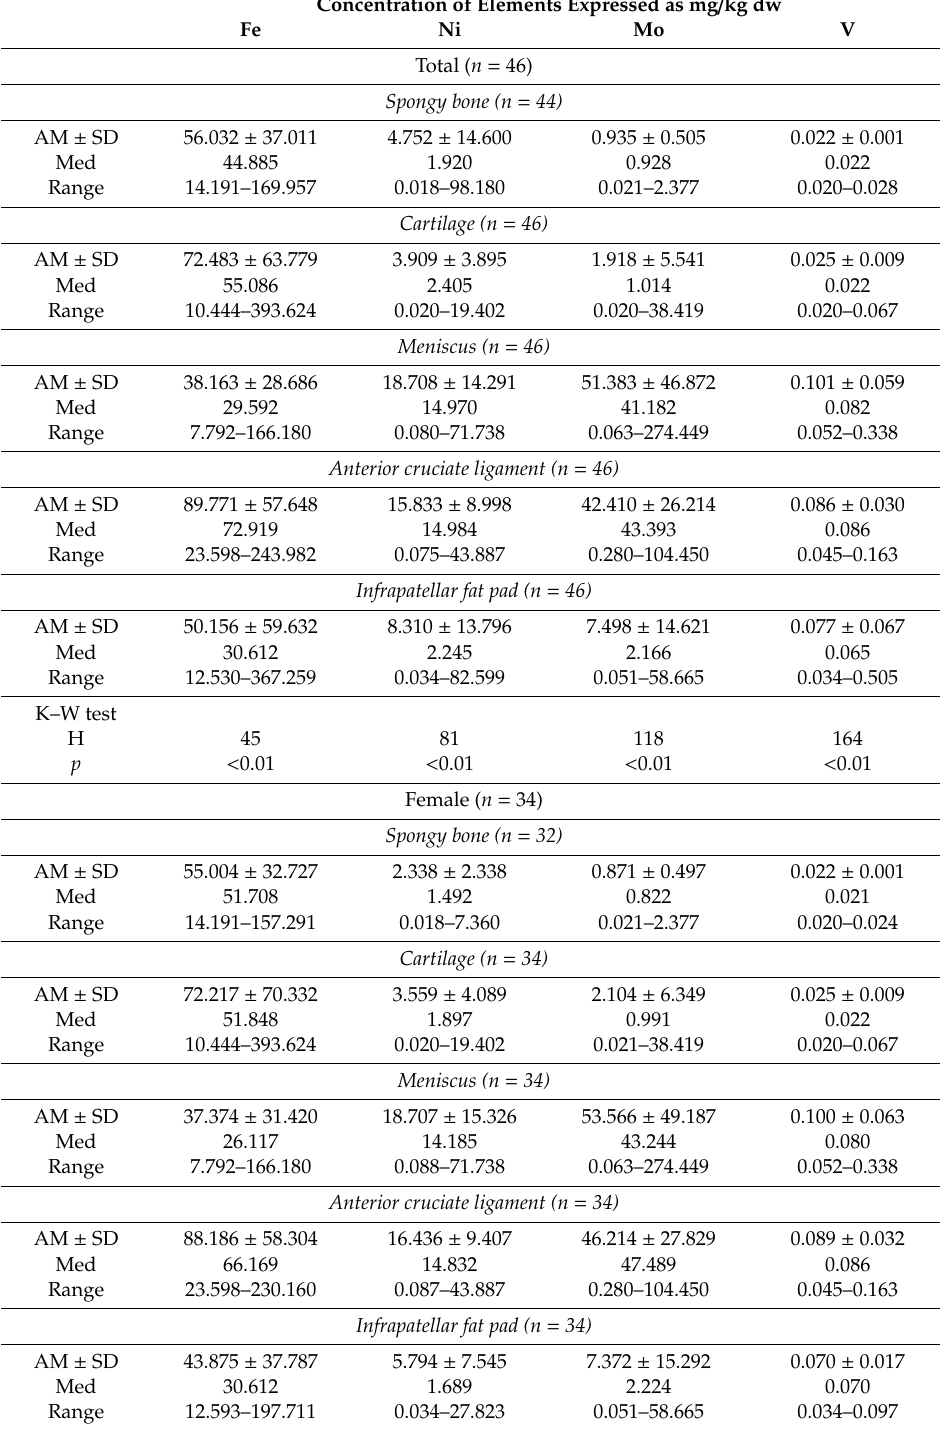
Table 2. The concentrations of iron, nickel, molybdenum, and vanadium in the spongy bone, cartilage, meniscus, anterior cruciate ligament, and infrapatellar fat pad in women and men ( n , number of samples; AM, arithmetic mean; SD, standard deviation; Med, median; K–W test, Kruskal–Wallis test; U, Mann–Whitney U test; p , level of significance; NS, non-significant di ff erence; concentrations expressed in mg / kg dry